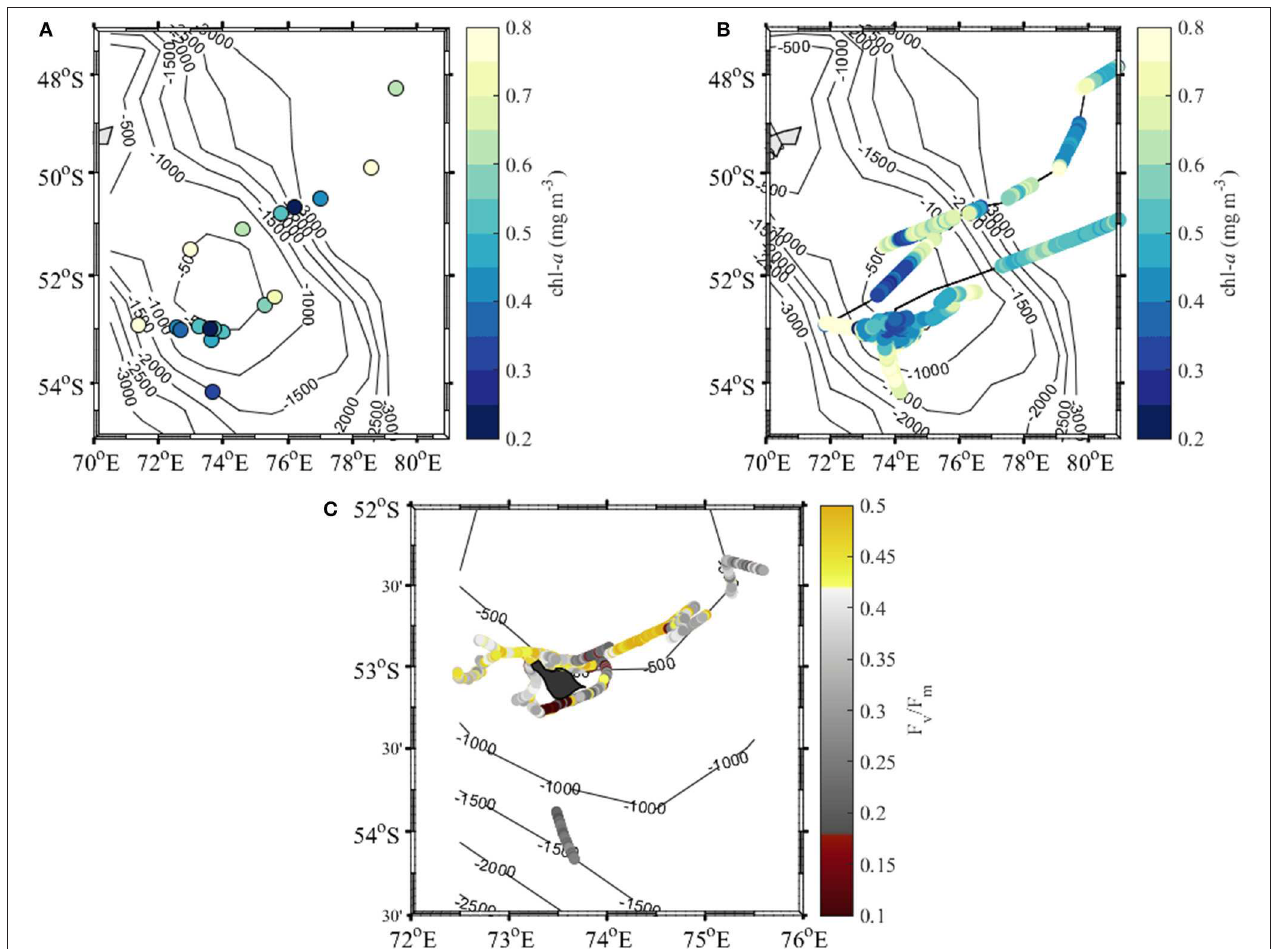
FIGURE 3 | Concentration of chlorophyll a (chl- a ) at the surface measured by (A) HPLC and (B) underway fluorometer, and (C) maximum quantum yield of photosystem II (PSII)—F v /F m in the vicinity of Heard and McDonald